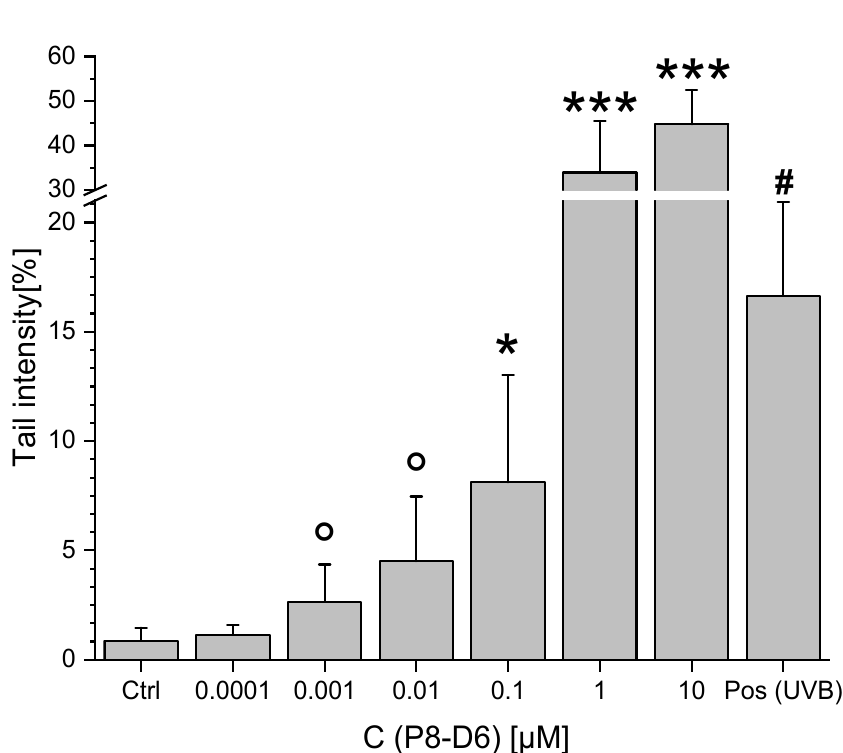
Figure 6. The induction of DNA strand breaks, measured in HT-29 cells by comet assay after 1 h incubation with P8-D6. Graphs show the tail intensity (a measure of genotoxicity) as mean + SD of at least five independent experiments, with UV-B radiation as positive control. Significant differences to the solvent control were calculated by one-way ANOVA followed by Fisher’s LSD test, and are indicated with “*” ( p < 0.05), “**” ( p < 0.01), and “***” ( p < 0.001), respectively. The values marked with “°” were not significantly different from the control when ANOVA was conducted with the full data, but became significant when the two highest concentrations of P8-D6 were excluded due to the high deviations at those concentrations. The significant difference between solvent and positive control was calculated using Student’s t -test ( p < 0.05) and is indicated with “#”.